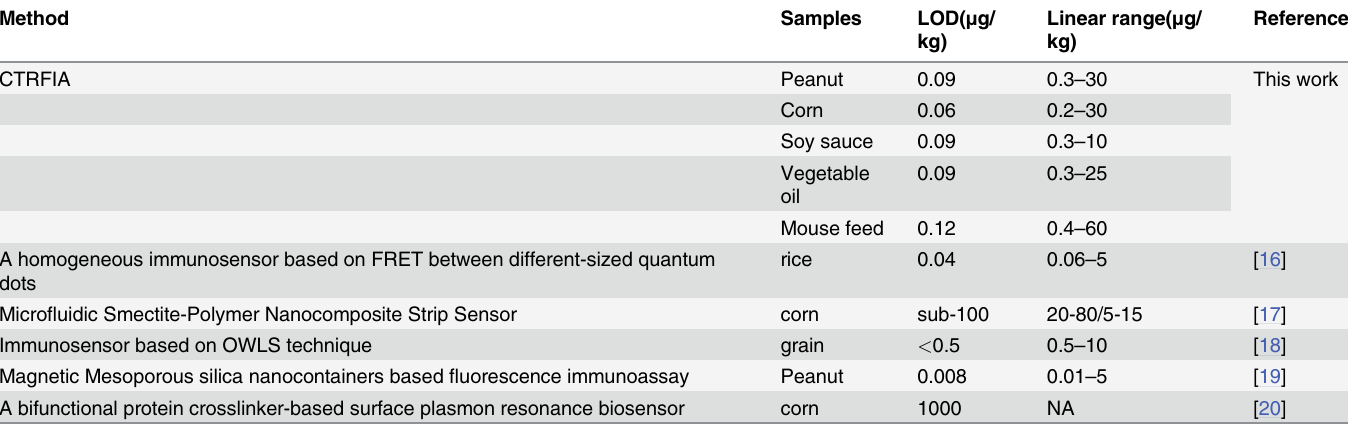
Table 2. Comparison of CTRFIA method with other reported sensing method for AFB 1 sensing.